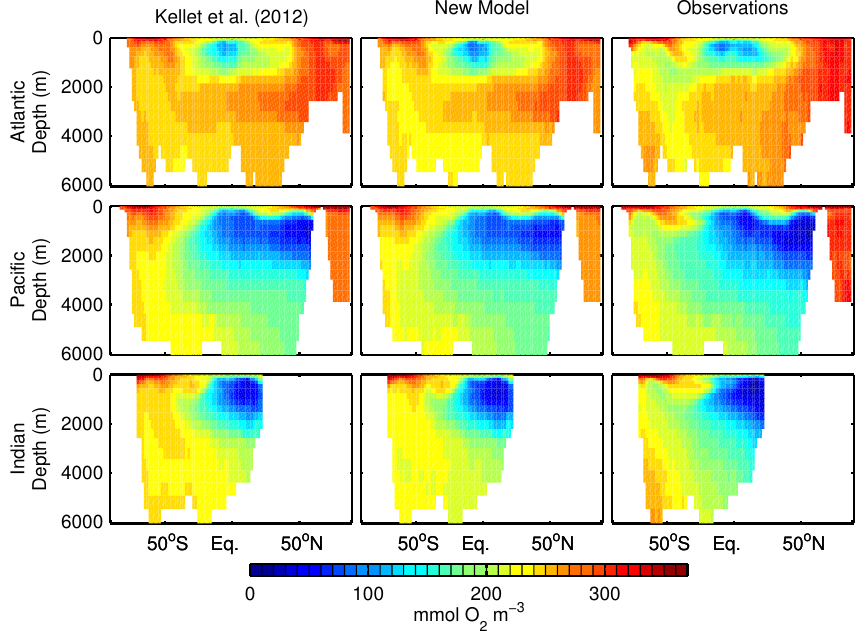
Figure 14. Zonal annual mean oxygen concentrations as simulated with the model by Keller et al. (2012) (left column) and the new model (middle column) in comparison to observations from the World Ocean Atlas 2009 (WOA, 2009) (Garcia et al., 2010a) (right column) for the different ocean